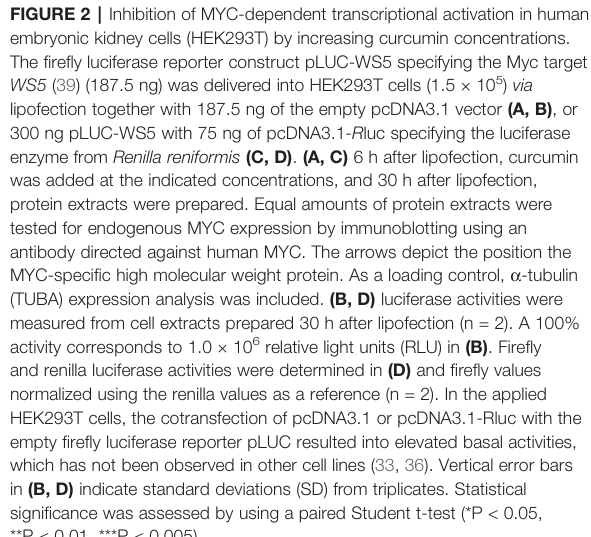
FIGURE 2 | Inhibition of MYC-dependent transcriptional activation in human embryonic kidney cells (HEK293T) by increasing curcumin concentrations. The fi re fl y luciferase reporter construct pLUC-WS5 specifying the Myc target WS5 (39) (187.5 ng) was delivered into HEK293T cells (1.5 × 10 5 ) via lipofection together with 187.5 ng of the empty pcDNA3.1 vector (A, B) , or 300 ng pLUC-WS5 with 75 ng of pcDNA3.1- R luc specifying the luciferase enzyme from Renilla reniformis (C, D) . (A, C) 6 h after lipofection, curcumin was added at the indicated concentrations, and 30 h after lipofection, protein extracts were prepared. Equal amounts of protein extracts were tested for endogenous MYC expression by immunoblotting using an antibody directed against human MYC. The arrows depict the position the MYC-speci fi c high molecular weight protein. As a loading control, a ‑ tubulin (TUBA) expression analysis was included. (B, D) luciferase activities were measured from cell extracts prepared 30 h after lipofection (n = 2). A 100% activity corresponds to 1.0 × 10 6 relative light units (RLU) in (B) . Fire fl y and renilla luciferase activities were determined in (D) and fi re fl y values normalized using the renilla values as a reference (n = 2). In the applied HEK293T cells, the cotransfection of pcDNA3.1 or pcDNA3.1-Rluc with the empty fi re fl y luciferase reporter pLUC resulted into elevated basal activities, which has not been observed in other cell lines (33, 36). Vertical error bars in (B, D) indicate standard deviations (SD) from triplicates. Statistical signi fi cance was assessed by using a paired Student t-test (*P < 0.05, **P < 0.01, ***P <